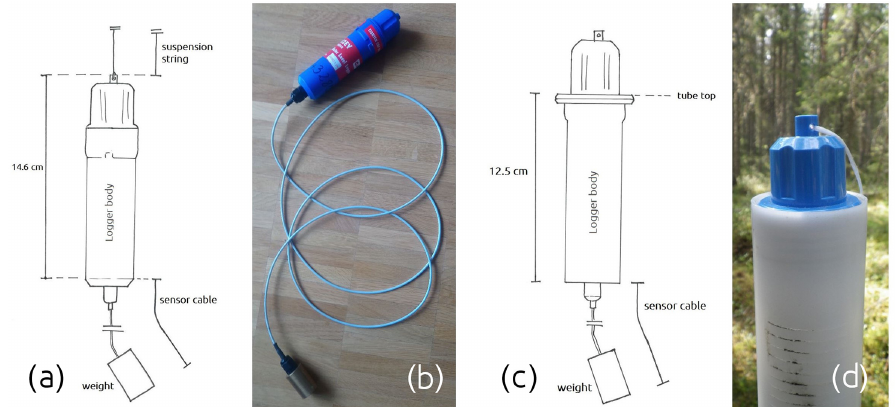
Figure E1. Odyssey water-level loggers and the lengths of the logger body and cable for the 2012 Odyssey water-level sensor (a, b) , the 2019 Odyssey water-level sensor (c) , and the 2019 sensor installed in a well tube (d) . Note that the drawings are not to